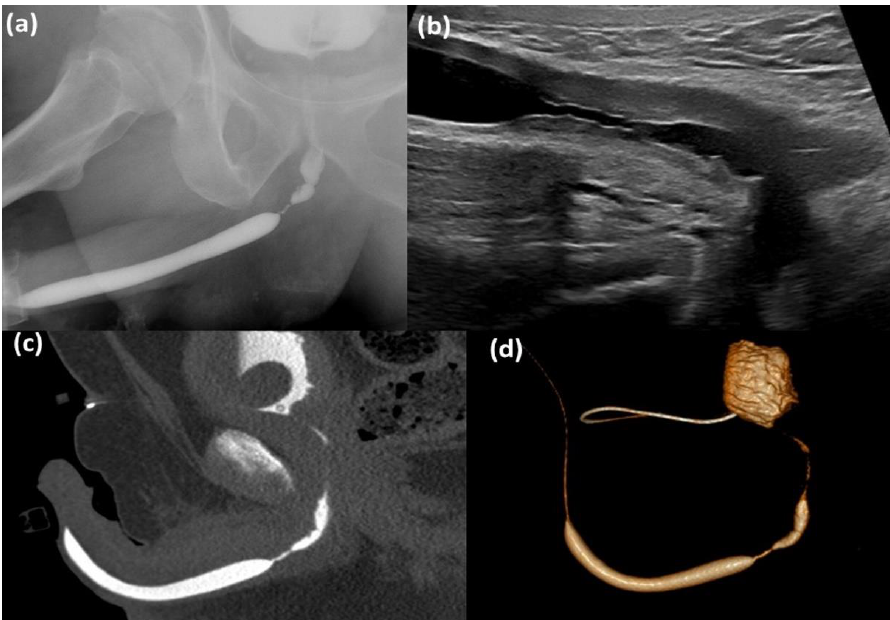
Figure 3. Patient with bulbar stenosis of a length underestimated by urethrography: ( a ) RUG showing 1.7 cm stenotic bulbar segment with a drastic reduction in the caliber of the urethral lumen; ( b ) retrograde sonourethrography (RSUG) showing the stenotic bulbar segment and surrounding spongiofibrosis, measuring 3.1 cm in total; ( c ) CT-RUG showing stenotic bulbar segment measuring 3.2 cm in length (measurement similar to RSUG and greater than RUG). ( d ): 3D CT-RUG image.